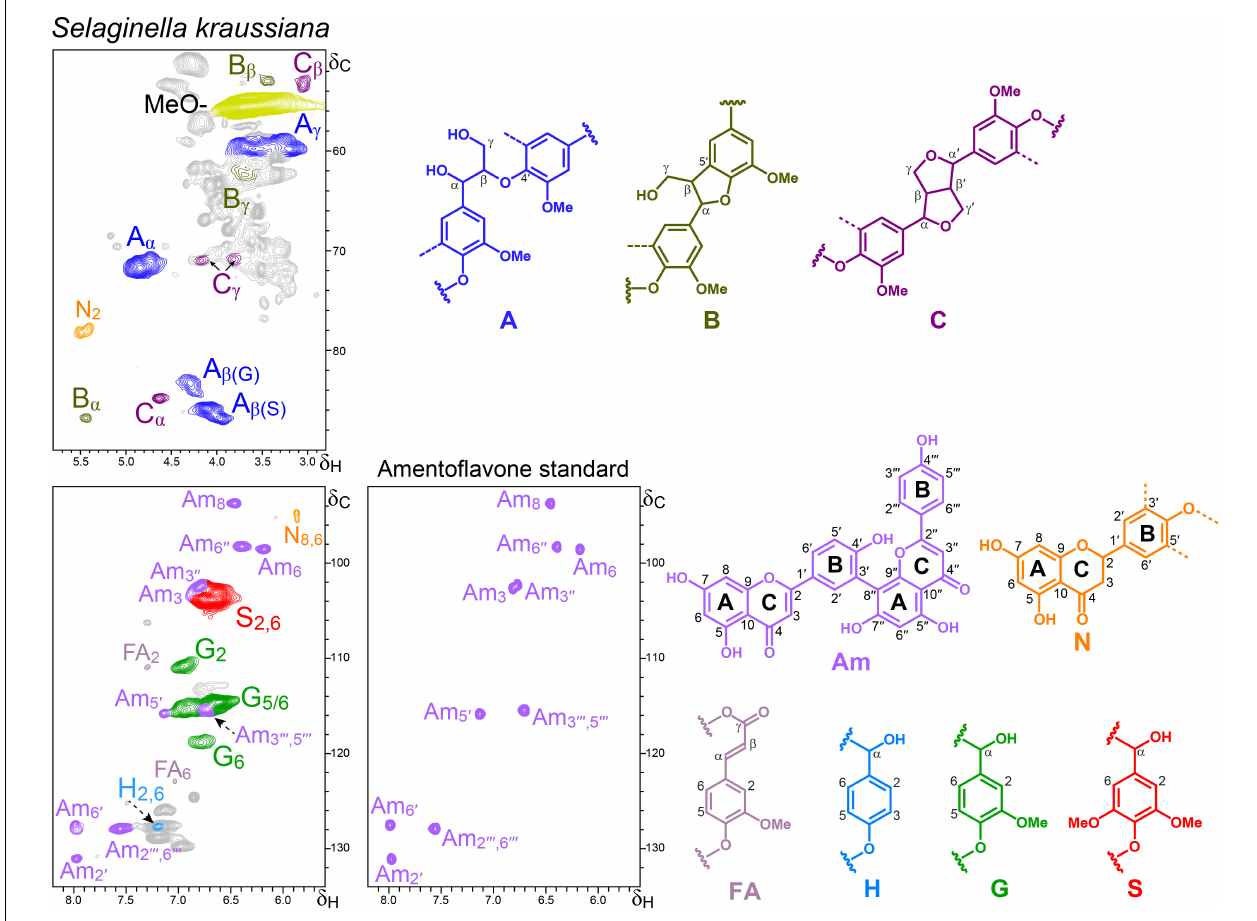
FIGURE 4 | Aliphatic-oxygenated ( δ C / δ H 50–90/2.8–5.8) and aromatic ( δ C / δ H 92–134/5.5–8.2) regions of the HSQC spectrum of the S. kraussiana lignin-like preparation. The HSQC spectrum of authentic amentoflavone is also shown for comparison. The main structures identified – corresponding to β – O –4 (cid:48) ether (A), β –5 (cid:48) phenylcoumaran (B) and β – β (cid:48) resinols (C) side chains, p -hydroxyphenyl (H), guaiacyl (G) and syringyl (S) units, and ferulic acid (FA), amentoflavone (Am) and naringenin (N) moieties – are